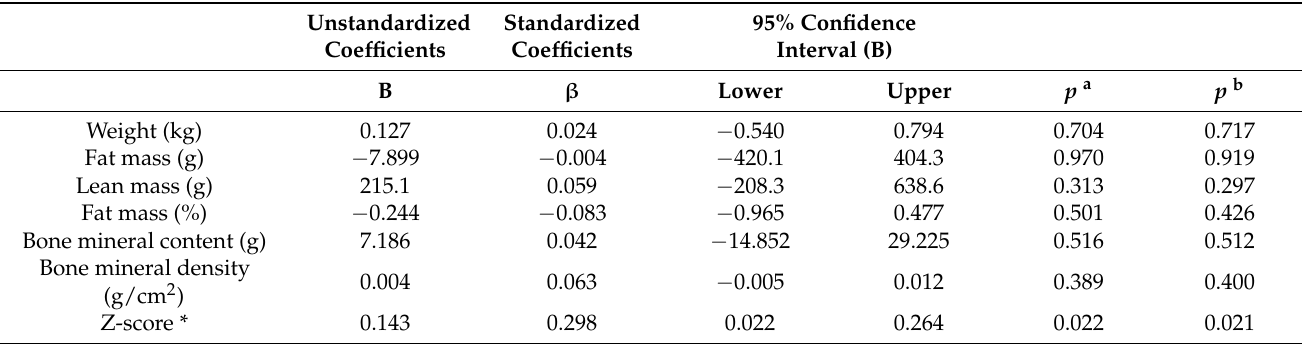
Table 4. Linear regression assessing the association between the Mediterranean Diet adherence and body composition in children with celiac disease ( n = 59).